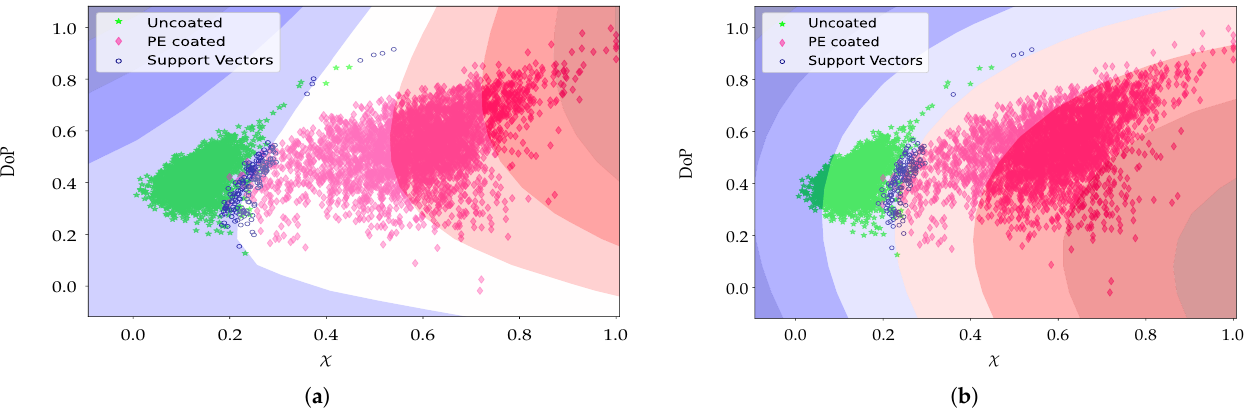
Figure 9. Feature space representation of the classification model of the binary classes PE- and non-PE-coated paperboard implemented with an ( a ) polynomial degree two and ( b ) SVM Gaussian kernel